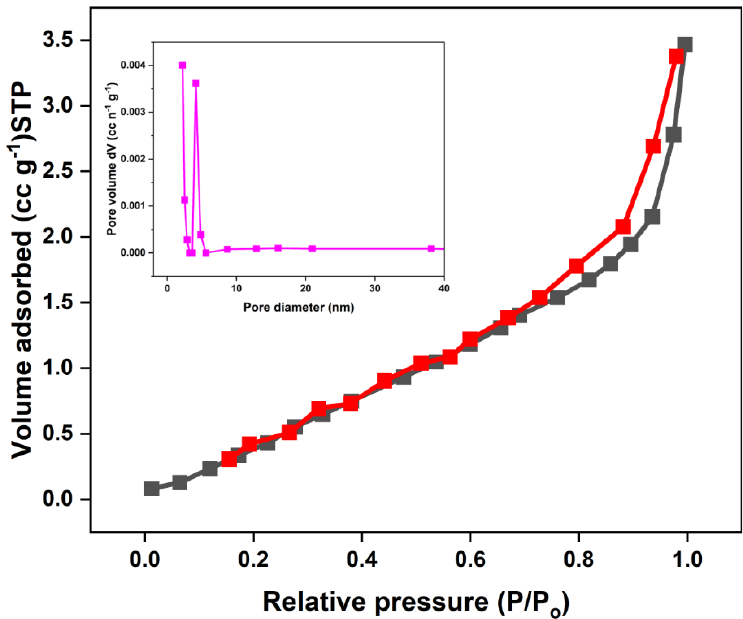
Figure 3. N 2 adsorption and desorption curve for the catalyst CaO−ZrO 2.